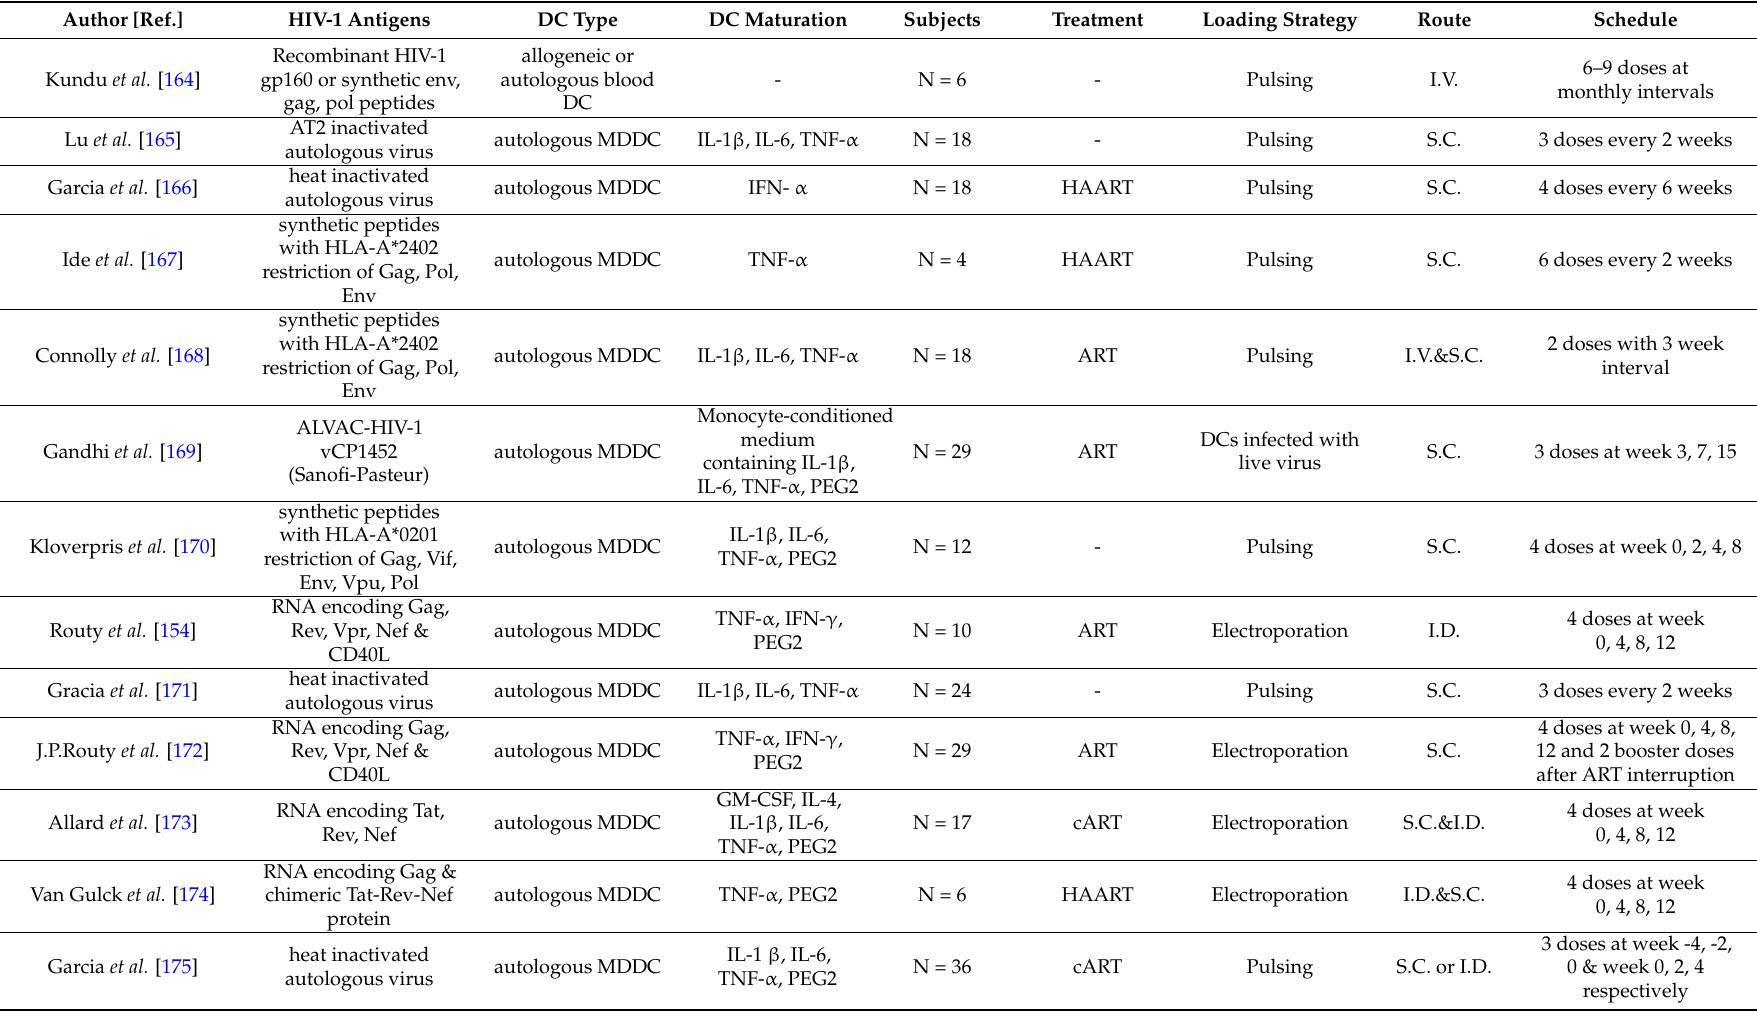
Table 1. Reported clinical trials of dendritic cell (DC)-based HIV-1 therapeutic